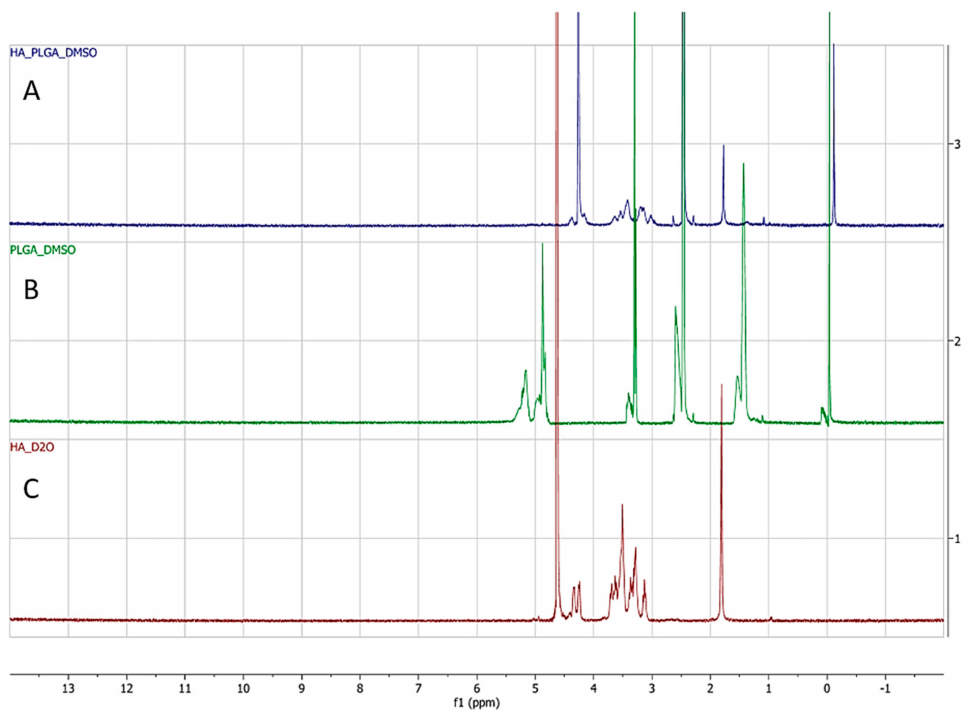
Figure 2. H 1 NMR spectrum for ( A ) HA-ss-PLGA graft co-polymer dissolved in DMSO, ( B ) PLGA polymer dissolved in DMSO, and ( C ) HA dissolved in D 2 O. Table 1. Full factorial design of experiment for hyaluronic acid-targeted, paclitaxel and